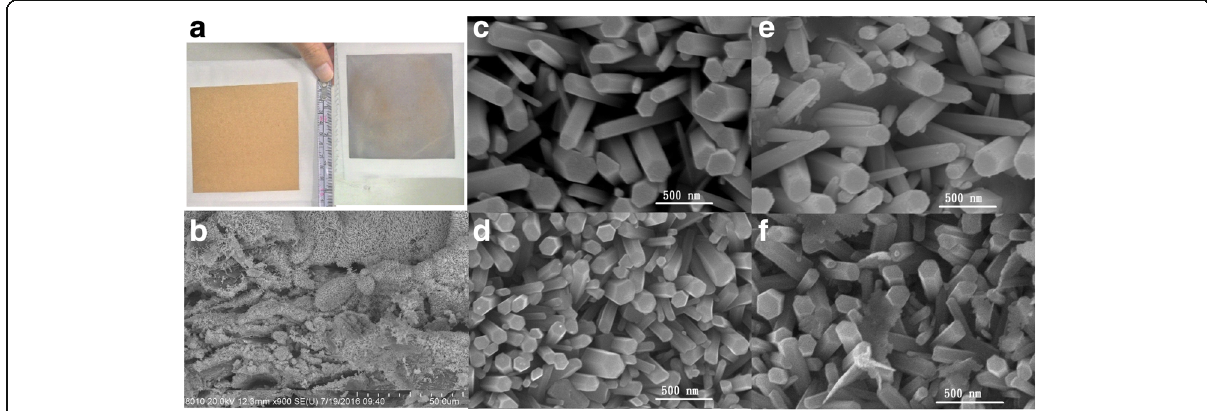
Fig. 1 a Photographs of a kraft paper substrate (left) and the paper with as-grown ZnO NRs (right). b SEM images of the ZnO NR paper. c – f SEM images of ZnO, Cu 2 O/ZnO, Ag/ZnO, and Ag/Cu 2 O/ZnO NRs,